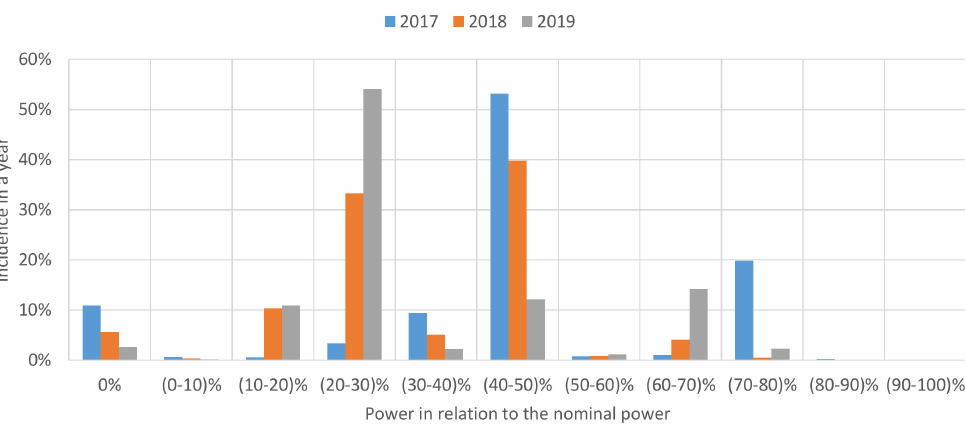
Figure 12. Percentage incidence of relative power generated for the hydroelectric power station.